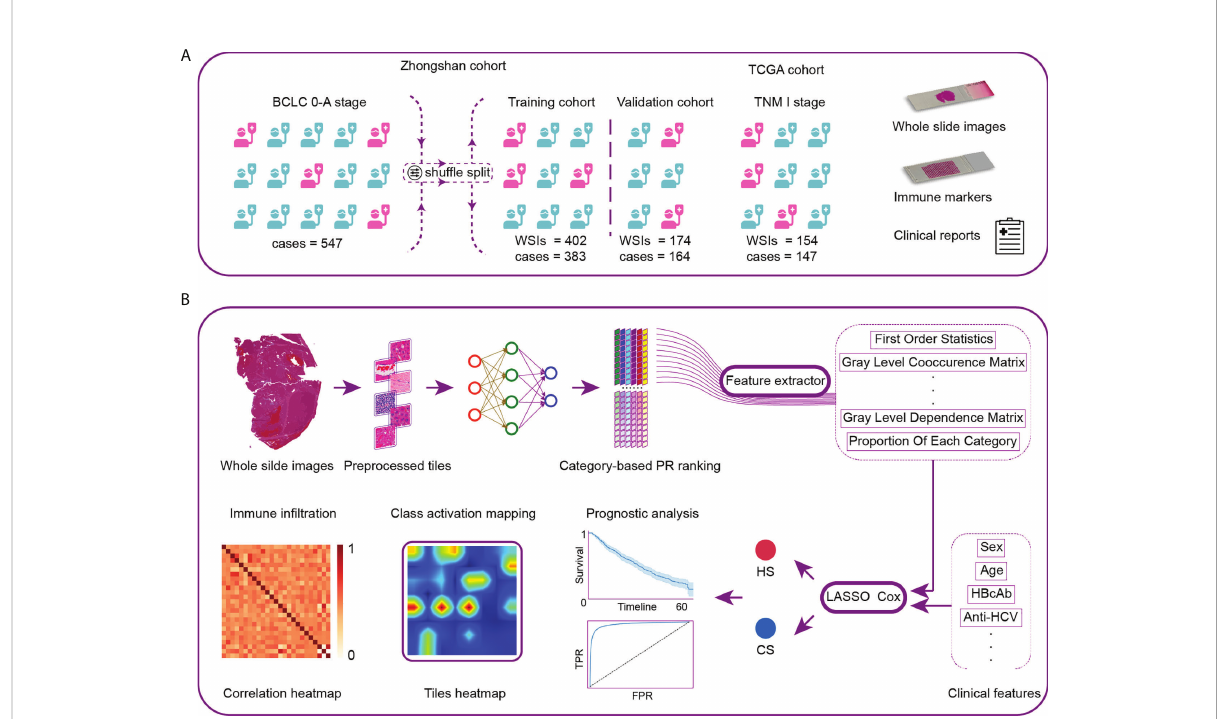
FIGURE 1 Work fl ow and general methodology of the study. (A) The recurrence-related scores were fi rst developed and internally validated in a series of patients with BCLC stage 0-A treated by curative resection at Zhongshan Hospital. The scores were then externally validated by TNM-I stage patients in the TCGA cohort. (B) We fi rst developed the neural network using 116 whole-slide images (WSIs) as the category-based training data. The network was then used to analyze the remaining WSIs and generate the classi fi cation maps. Pathological image features were extracted from typical tiles. Next, we constructed two recurrence prediction scores via LASSO-Cox. CS was composed of clinical and histological characteristics. HS was developed based on pure histological features. Finally, we analyzed the model discrimination ability, patient prognosis and local immune cell in fi ltration. TCGA, The Cancer Genome Atlas; PR, precision-recall; CS, combined score; HS, histological score; TPR, true positive rate; FPR, false positive